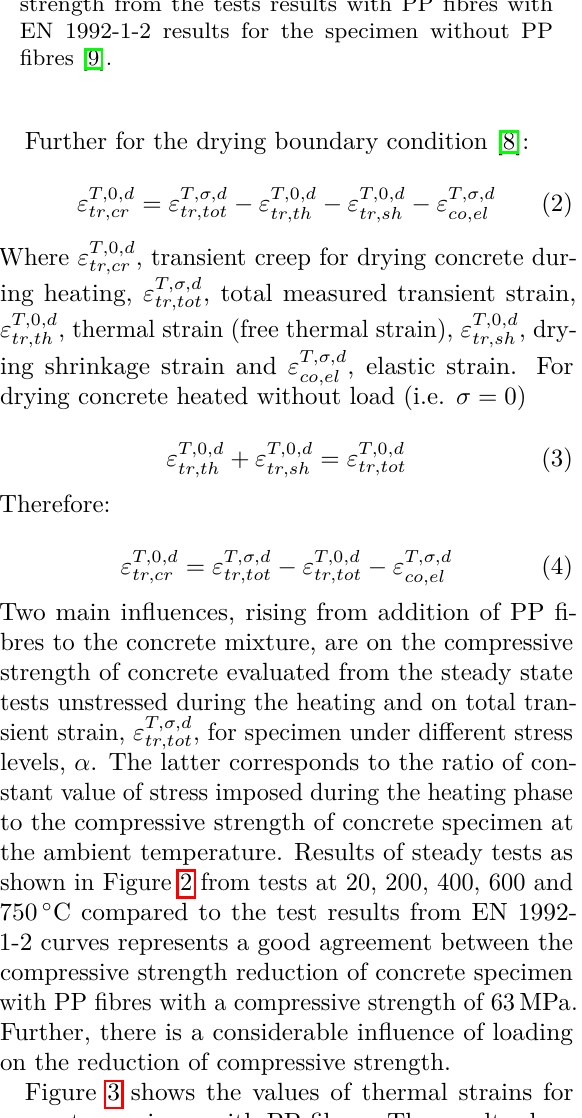
Figure 3. Total strain vs. temperature for specimen with PP fibres